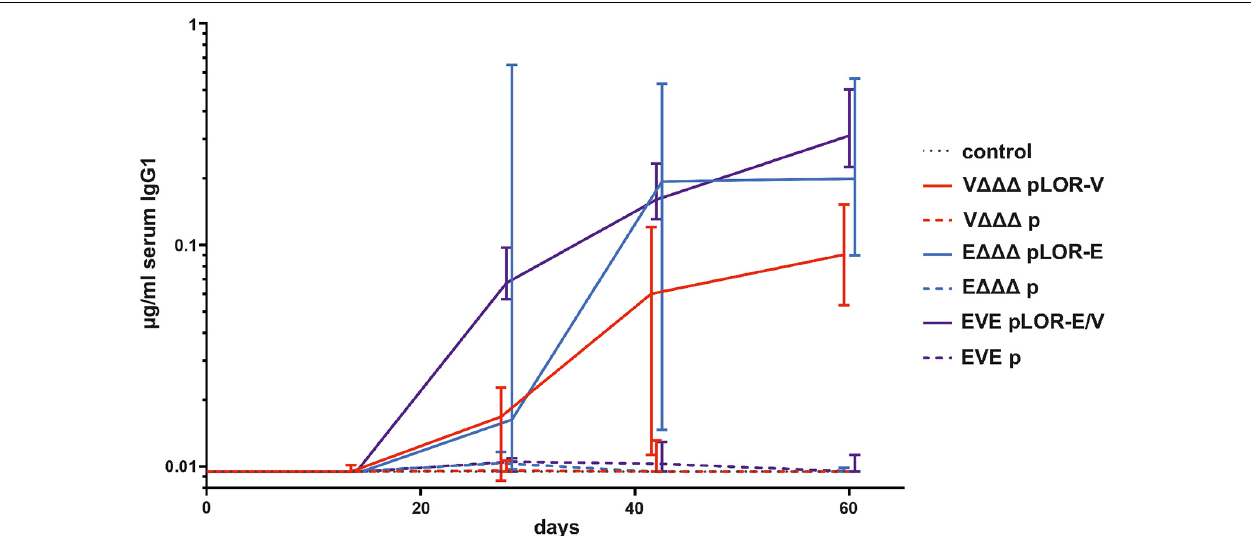
FIGURE 4 | Temporal immune responses against the SARS-CoV-2 Spike protein. Shown are the median titers over time of IgG1 antibodies to SARS-CoV-2 Spike protein in sera from mice intranasally immunized with OMVs derived from V (cid:49)(cid:49)(cid:49) pLOR-V (red solid line), V (cid:49)(cid:49)(cid:49) p (red dashed line), E (cid:49)(cid:49)(cid:49) pLOR-E (blue solid line), E (cid:49)(cid:49)(cid:49) p (blue dashed line), and from the sham-immunized control group (gray dotted line). Moreover, two groups were intranasally immunized with alternating regimen and received OMVs from E (cid:49)(cid:49)(cid:49) pLOR-E on days 0 and 28 as well as OMVs from V (cid:49)(cid:49)(cid:49) pLOR-V on day 14 (EVE pLOR-E/V, purple solid line) or OMVs from E (cid:49)(cid:49)(cid:49) p on days 0 and 28 as well as V (cid:49)(cid:49)(cid:49) p on day 14 (EVE p, purple dashed line). Samples which did not yield in any detectable signal at their highest concentration were set to the limit of detection (0.01 µ g/ml). The error bars indicate the interquartile range of each data set for each time point ( n = 7 for each group).